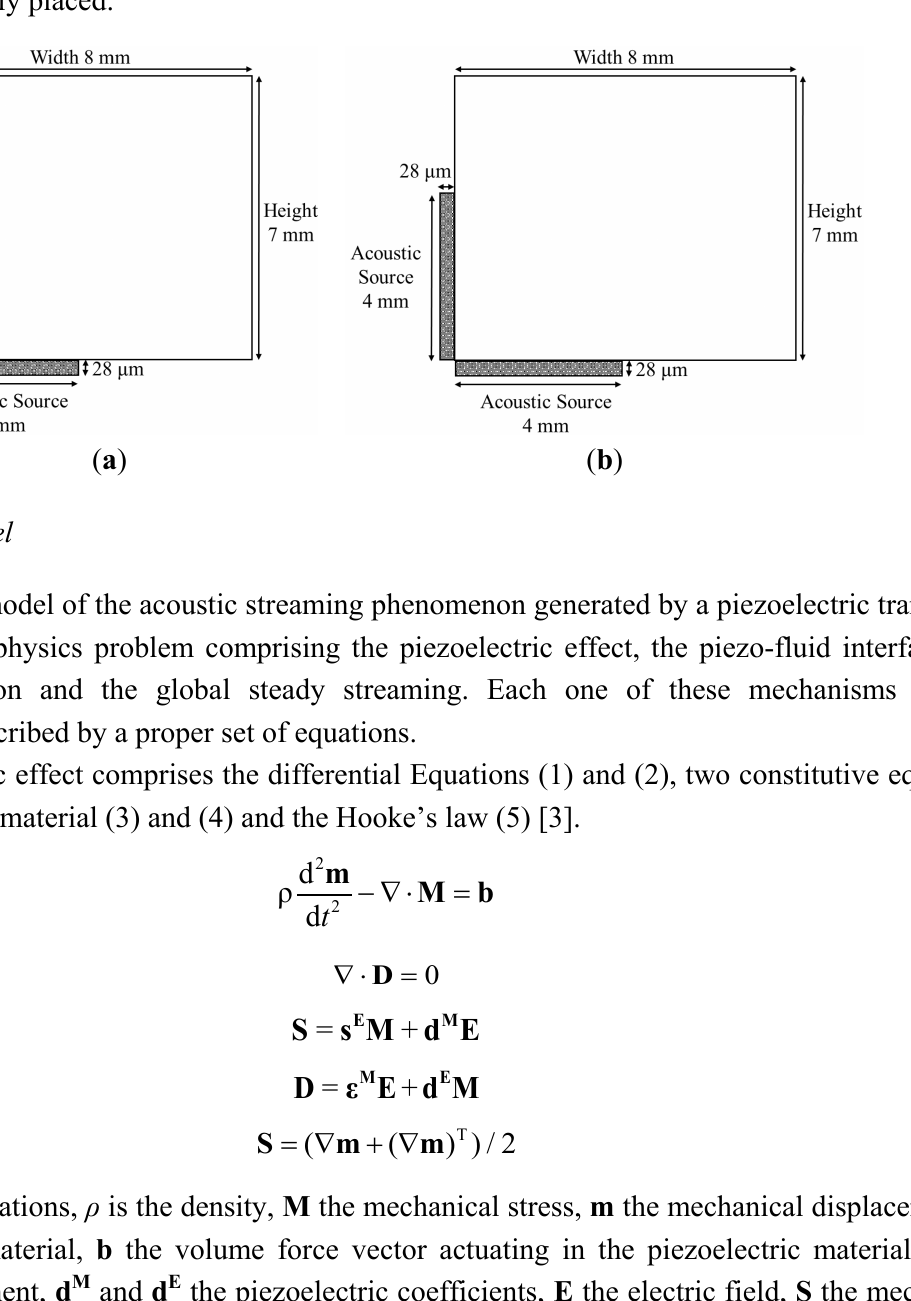
Figure 1. Macroscale version of the cuvette and piezoelectric transducers positioning for studying the acoustic streaming phenomena. ( a ) One transducer. ( b ) Two transducers perpendicularly